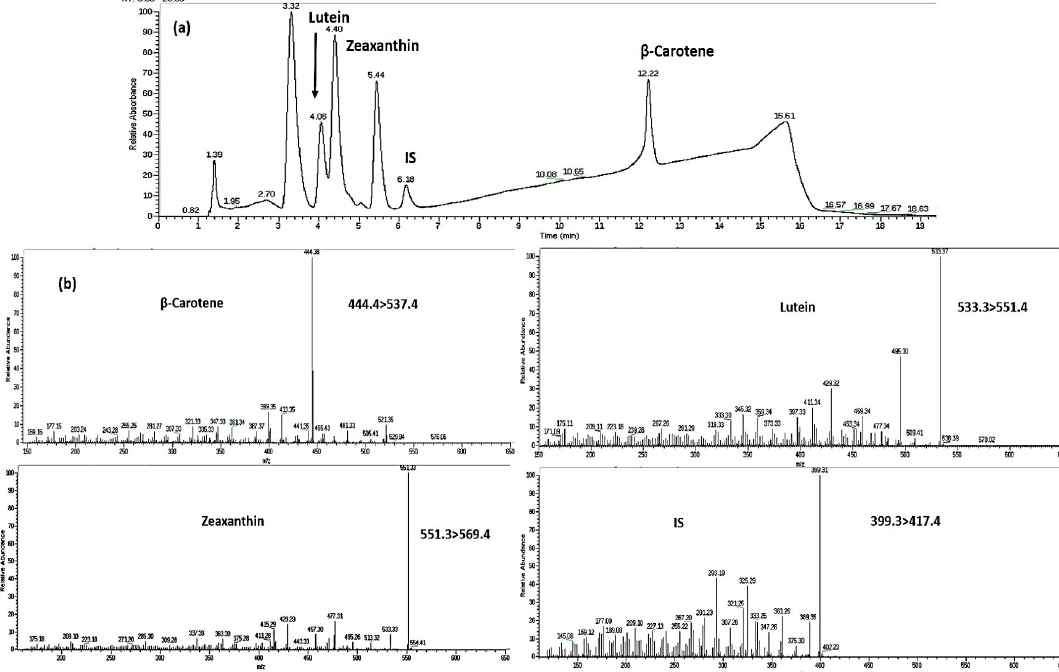
Figure 1. Carotenoids’ ( a ) chromatographic peaks and ( b ) mass transitions.